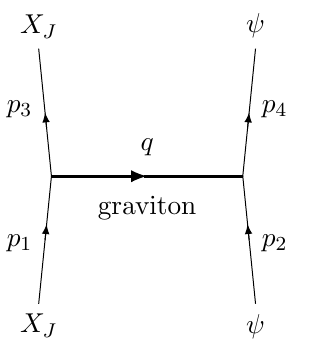
Figure 8 . Eikonal scattering of hadrons ( X J ) in large N gauge theory with a spectating scalar ψ . The scalar can only interact with other particles via